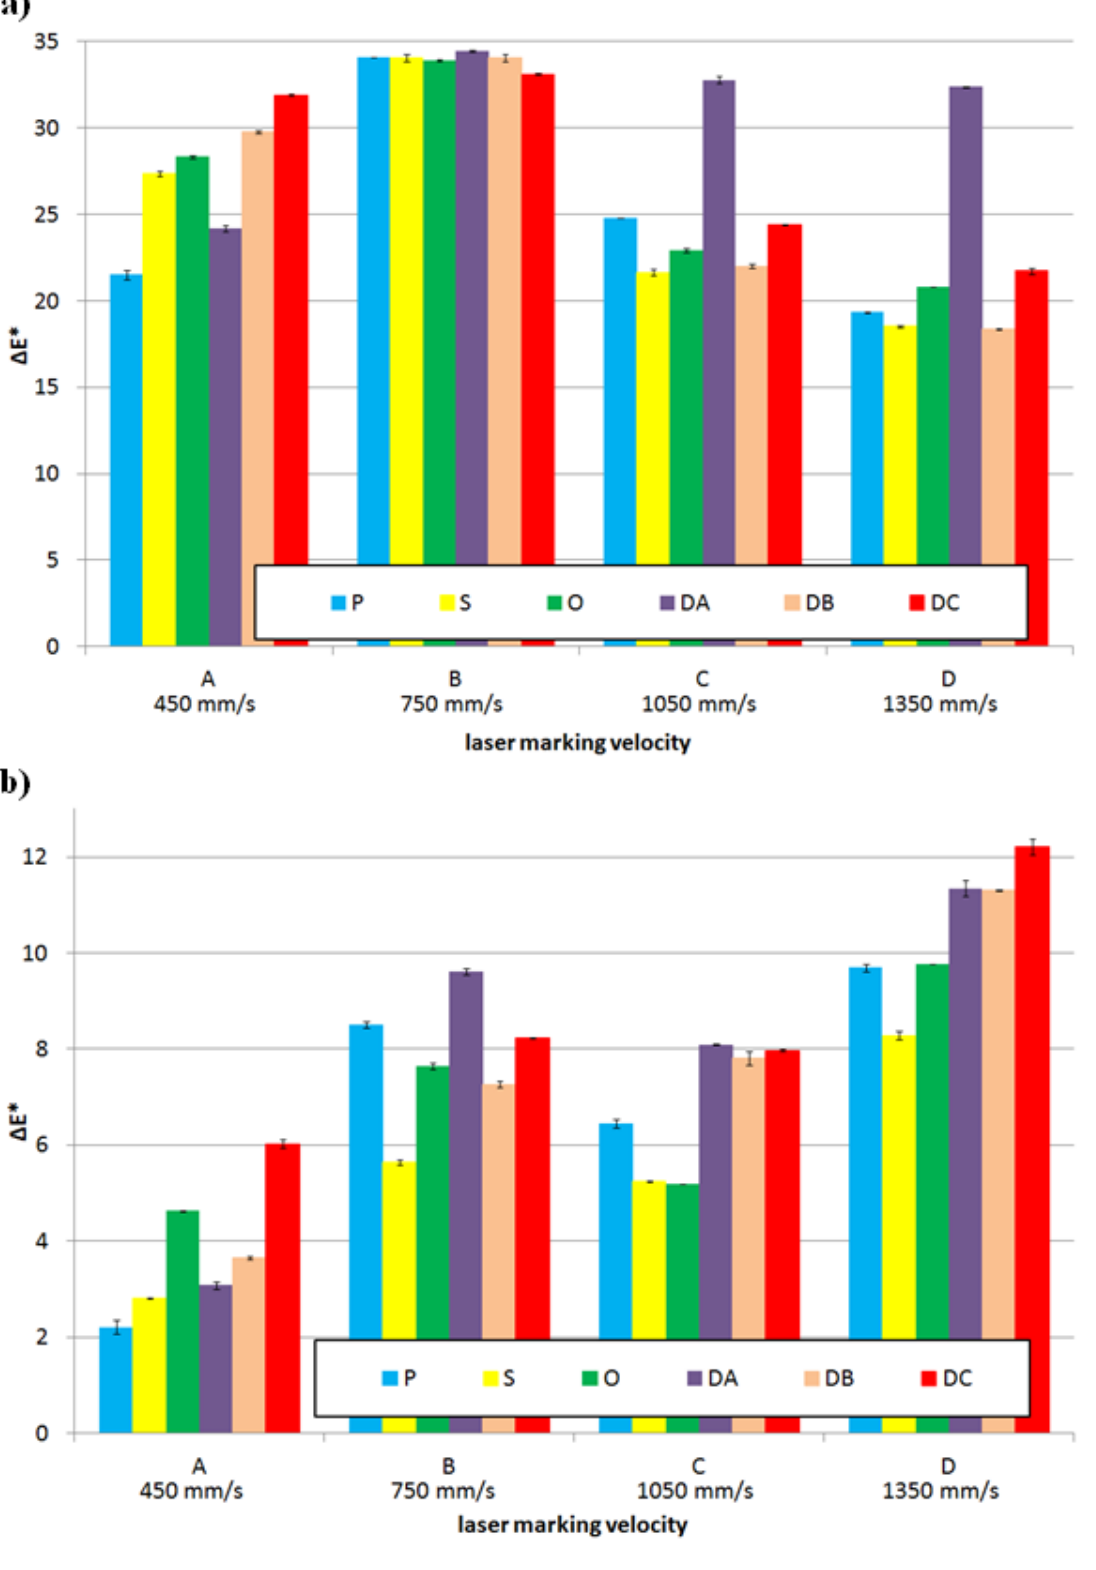
Figure 4. Influence of the additive content absorbing laser energy on the ∆ E * (general color deviation) parameter in relationship to a surface used and a laser marking velocity: ( a ) 0.0 wt% of the LMA additive content and ( b ) 2.5 wt% of the LMA additive content.